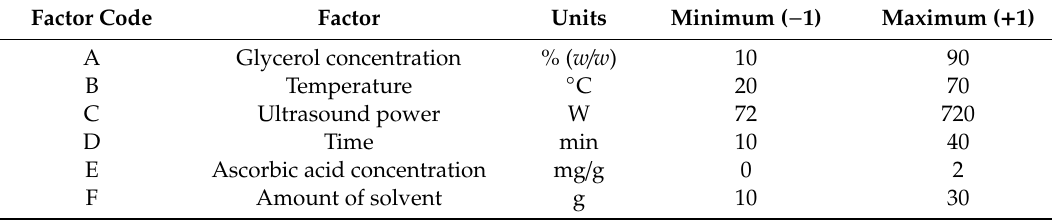
Table 2. The independent variables and their levels for the two-level factorial